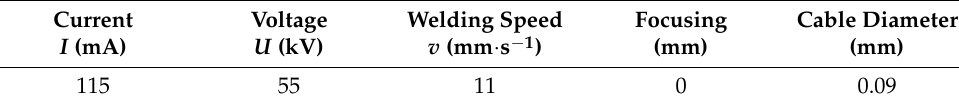
Table 5. Parameters of electron welding.